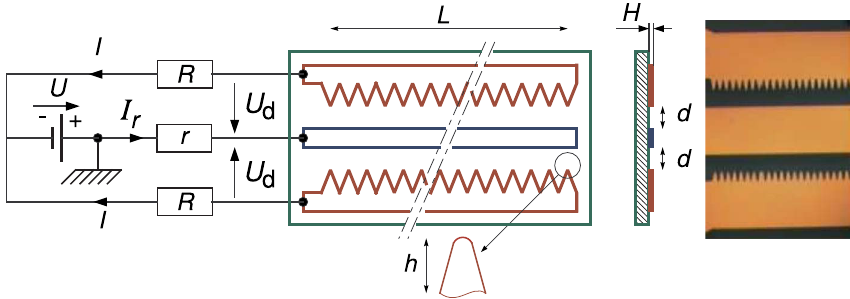
Figure 2. Left side: schematic representation of the microdischarge microphone – two-dimensional setup. Two electrodes with 170 points and a wire electrode. d = 100 l m, L = 17 mm, H = 450 l m, h = 170 l m with a tip radius of approximately 20 l m. R ’ 23 M X and r ’ 50 X are the values of the ballast and shunt resistance. Right side: photograph of a microplasma